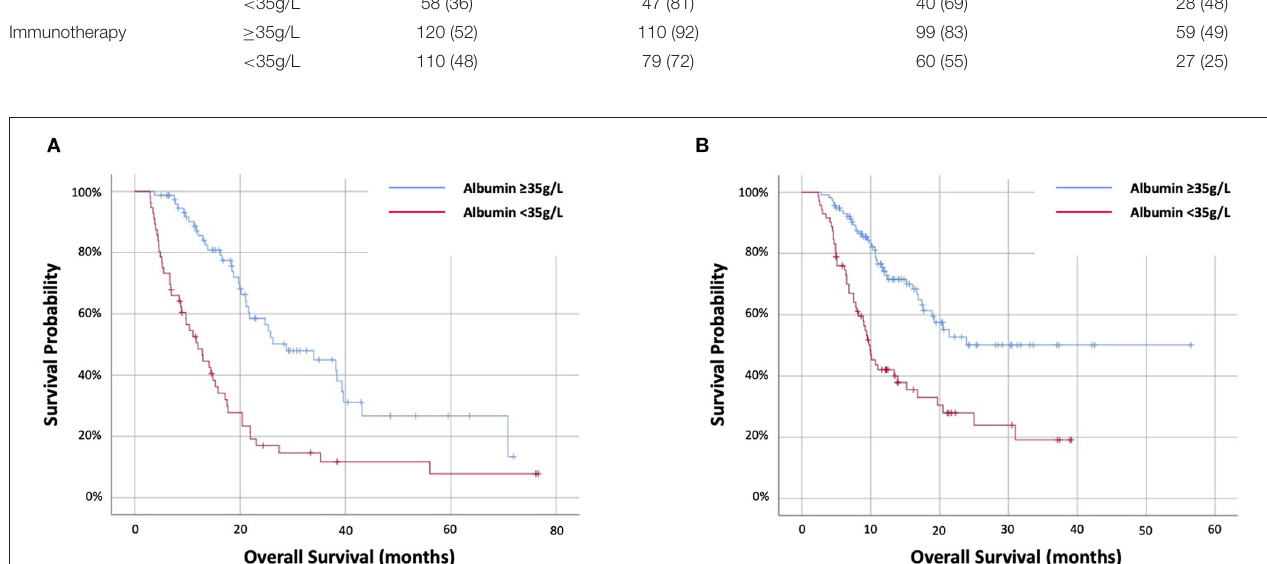
FIGURE 2 | Kaplan–Meier survival curves examing the relationship between 12-week albumin and overall survival of patients with NSCLC treated with first-line (A) targeted therapy or (B) immunotherapy-based therapy.